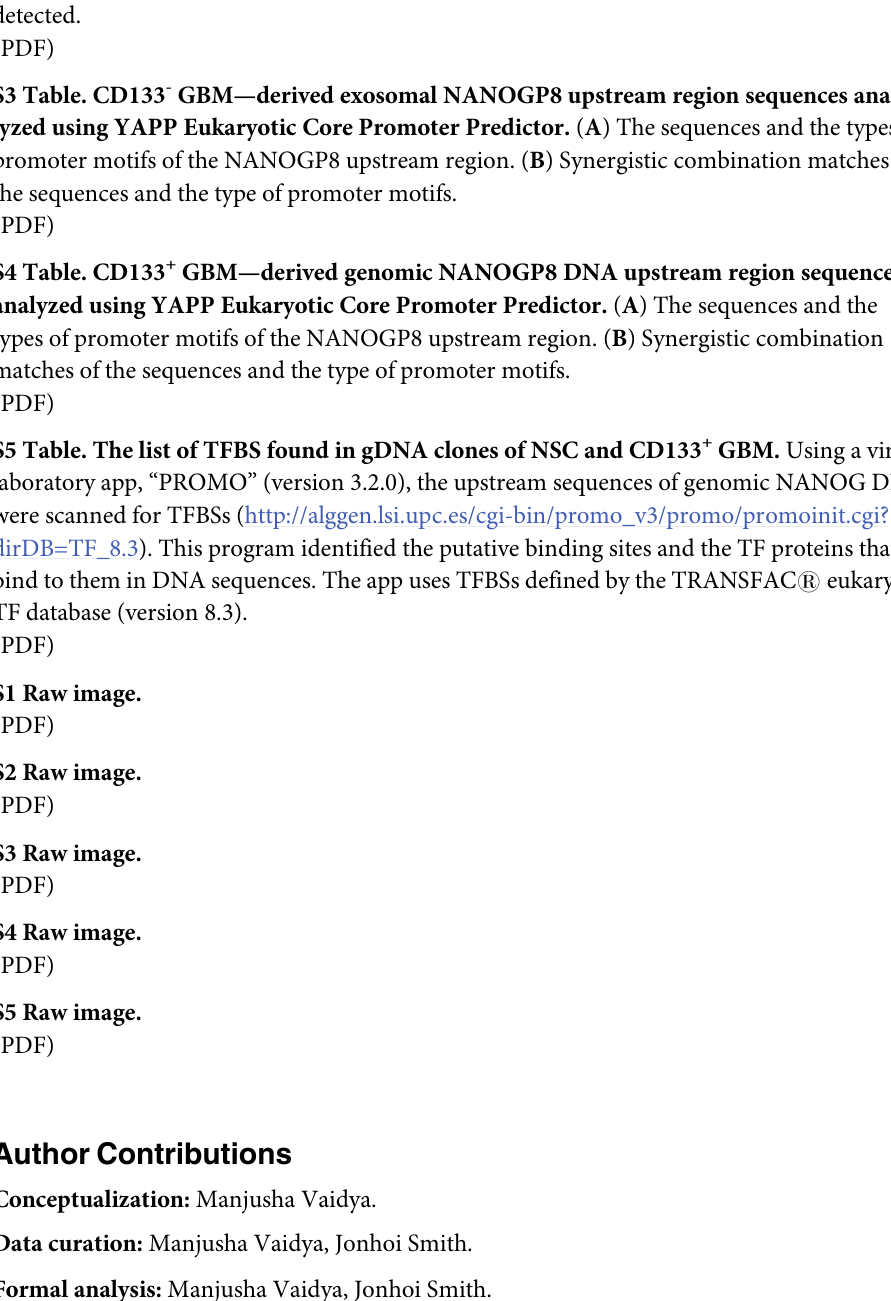
S1 Table. NSC- derived exosomal NANOGP8 upstream region sequences analyzed using YAPP Eukaryotic Core Promoter Predictor. ( A ) The sequences and the types of promoter motifs of the NANOGP8 upstream region. ( B ) Synergistic combination matches of the sequences and the type of promoter motifs. S2 Table. GBM-derived exosomal NANOGP8 upstream region sequences analyzed using YAPP Eukaryotic Core Promoter Predictor. The sequences and the types of promoter motifs of the NANOGP8 upstream region. No synergistic combination matches of the sequences was detected. S3 Table. CD133 - GBM—derived exosomal NANOGP8 upstream region sequences ana- lyzed using YAPP Eukaryotic Core Promoter Predictor. ( A ) The sequences and the types of promoter motifs of the NANOGP8 upstream region. ( B ) Synergistic combination matches of the sequences and the type of promoter motifs. S4 Table. CD133 + GBM—derived genomic NANOGP8 DNA upstream region sequences analyzed using YAPP Eukaryotic Core Promoter Predictor. ( A ) The sequences and the types of promoter motifs of the NANOGP8 upstream region. ( B ) Synergistic combination matches of the sequences and the type of promoter motifs. S5 Table. The list of TFBS found in gDNA clones of NSC and CD133 + GBM. Using a virtual laboratory app, “PROMO” (version 3.2.0), the upstream sequences of genomic NANOG DNA were scanned for TFBSs (http://alggen.lsi.upc.es/cgi-bin/promo_v3/promo/promoinit.cgi? dirDB=TF_8.3). This program identified the putative binding sites and the TF proteins that bind to them in DNA sequences. The app uses TFBSs defined by the TRANSFAC 1 eukaryotic TF database (version